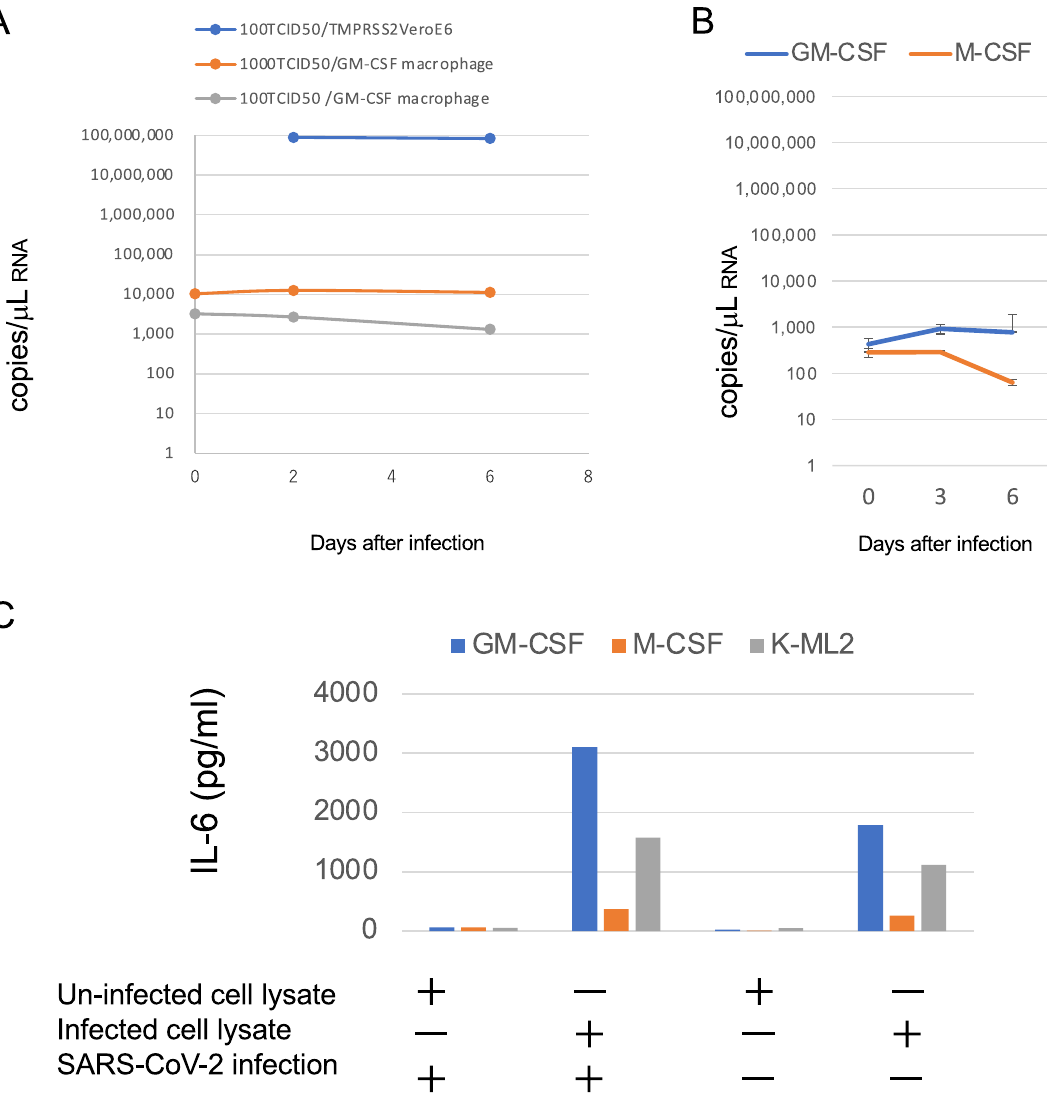
Figure 1. IL-6 production induced by SARS-CoV-2-infected cell lysate in monocyte-derived macrophages (MDM) and iPS-derived myeloid cells without productive infection. ( A ) Peripheral blood monocytes were differentiated into MDM by adding GM-CSF for 8 days. TMPRSS2/VeroE6 cells and MDM were infected with 1000 50% tissue culture infectious dose (TCID50) or 100 TCID50 of SARS-CoV-2 (JPN-TY-Wk-521 strain) and the viral RNA in the supernatants was measured by RT-PCR on the indicated days. ( B ) GM-CSF- or M-CSF- MDM were infected with 100 TCID50 of KNG-19-020 strain of SARS-CoV-2. ( C ) iPS-derived myeloid cells K-ML2 (gray) and GM-CSF- (blue) and M-CSF- (red) MDM were inoculated with the SARS-CoV-2 KNG-19- 020 strain together with SARS-CoV-2-infected or uninfected cell lysate. Two days after infection, the IL-6 levels in the culture supernatants were measured by ELISA. The representative results of at least three independent experiments are